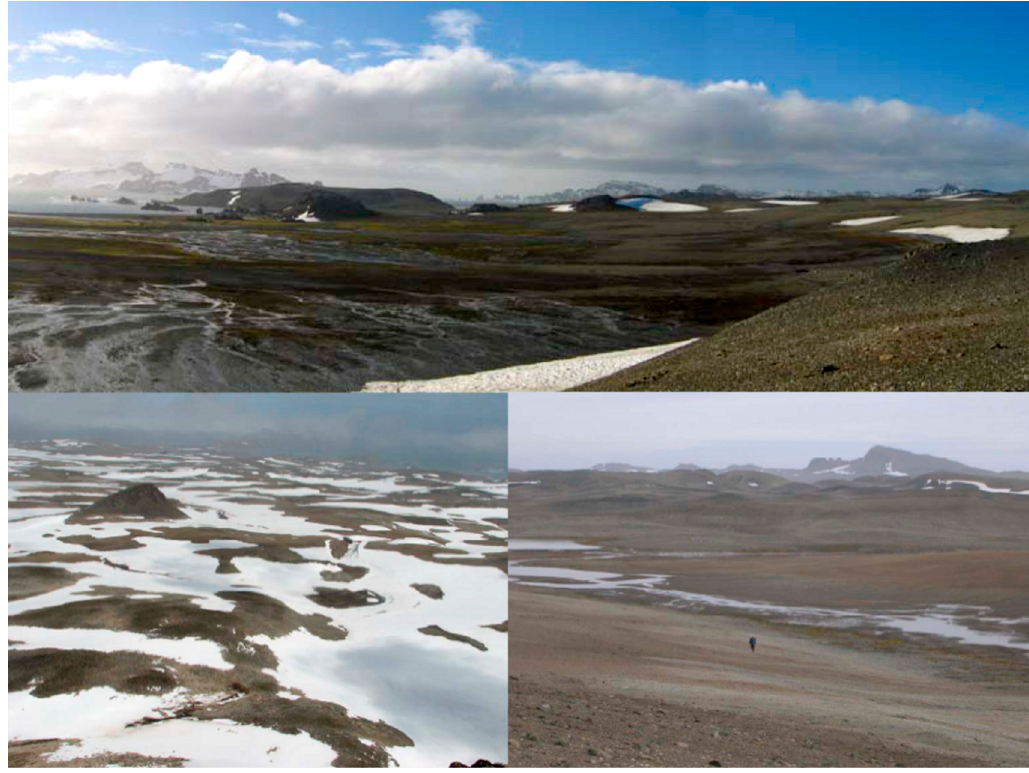
Figure 3. Landscape photographs showing components of the drainage network of Byers Peninsula.